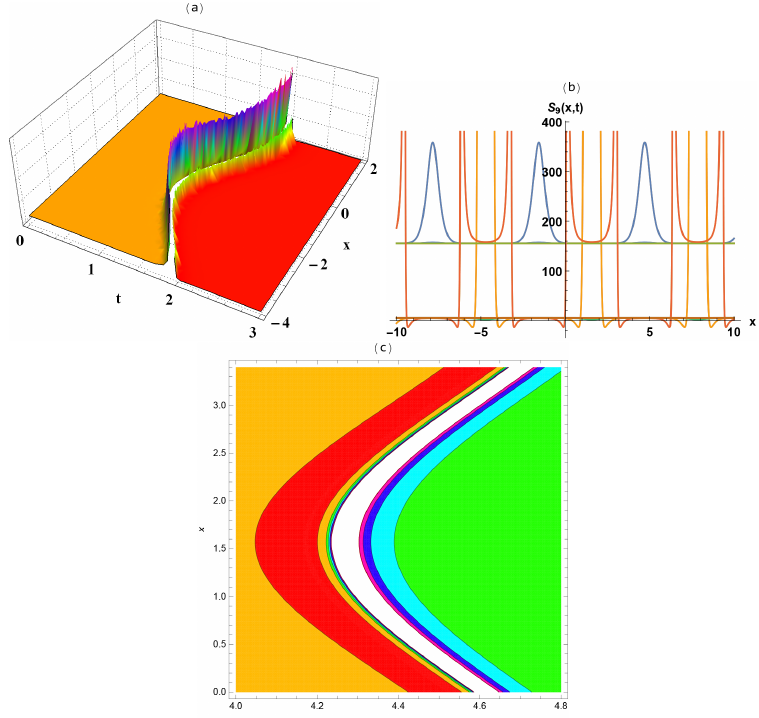
(cid:21) = 3 . (cid:48)